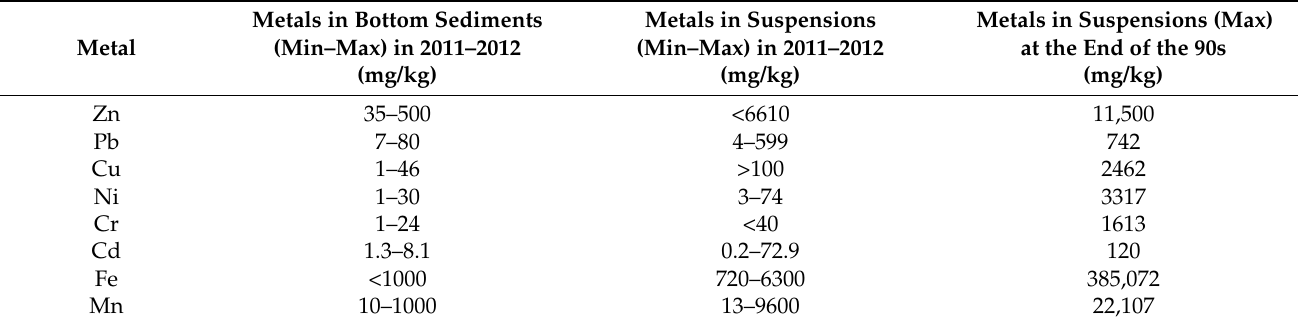
Table 1. A comparison of heavy metal content compared to the dry mass of suspensions in bottom sediments and suspensions in the Kłodnica taken at eight measuring points